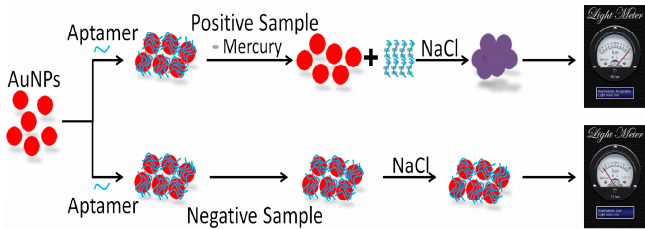
Figure 2. Schematic illustration of the workflow for the smartphone-based microwell reader (MR S-phone)-based Hg 2+ colorimetric detection system. In the absence of heavy metal contaminants (lower), the aptamer adsorbs to AuNPs, which protects the AuNPs from aggregation induced by the addition of high-concentration salt. In Hg 2+ -positive samples, the aptamers are competed away from AuNPs by Hg 2+ . Therefore, when the solution is treated with NaCl, the AuNPs aggregate, and the solution changes to blue. The light meter app is then used in combination with the phone attachment to detect the transmitted light intensity of each sample. When Hg 2+ is present, the MR S-phone system detects an increase in transmitted light intensity. When samples lack Hg 2+ , the AuNPs are protected by the aptamers in high-concentration salt; therefore, the solution remains red, and no change in transmitted light intensity is detected.